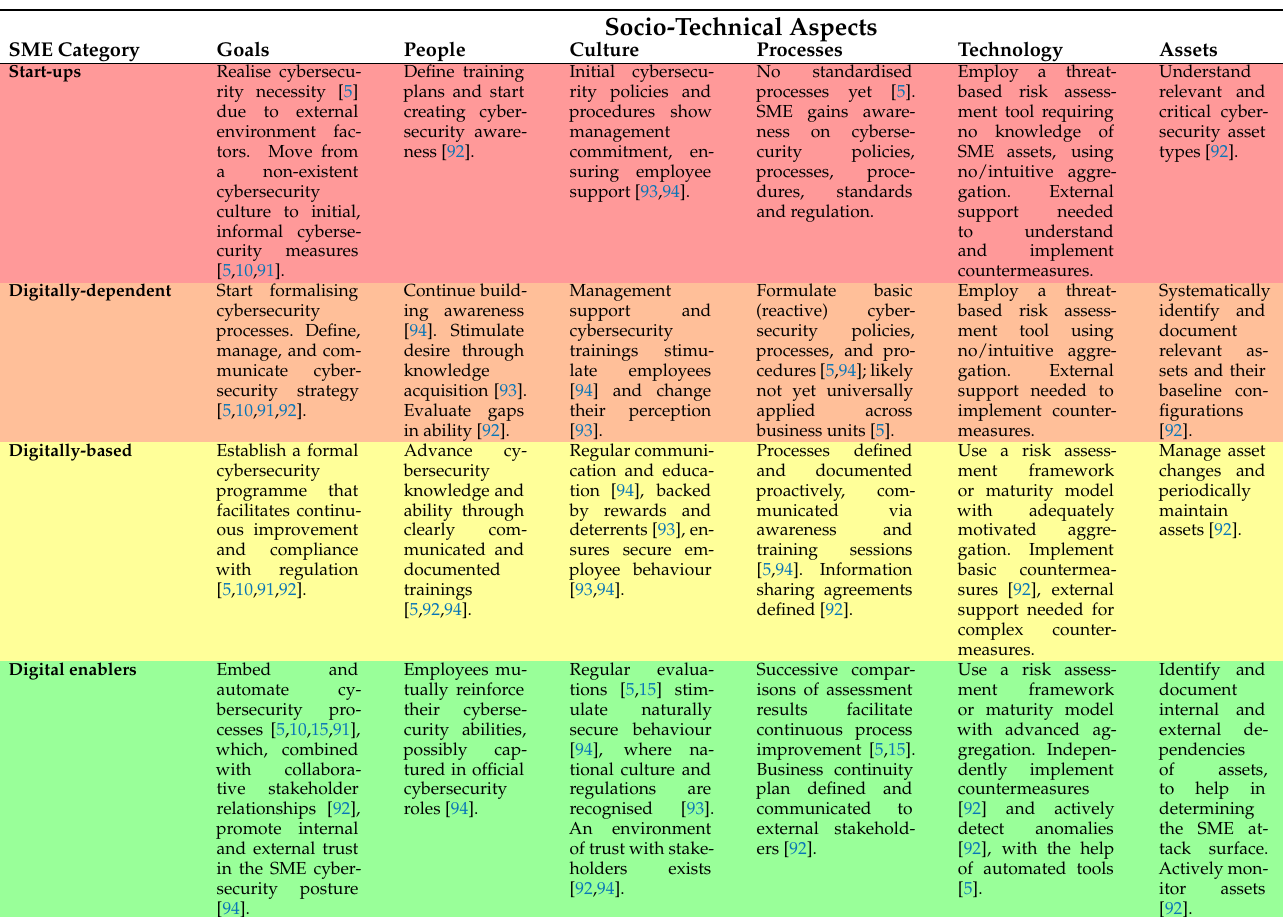
Table 10. Socio-technical cybersecurity framework for SMEs. Socio-Technical Aspects SME